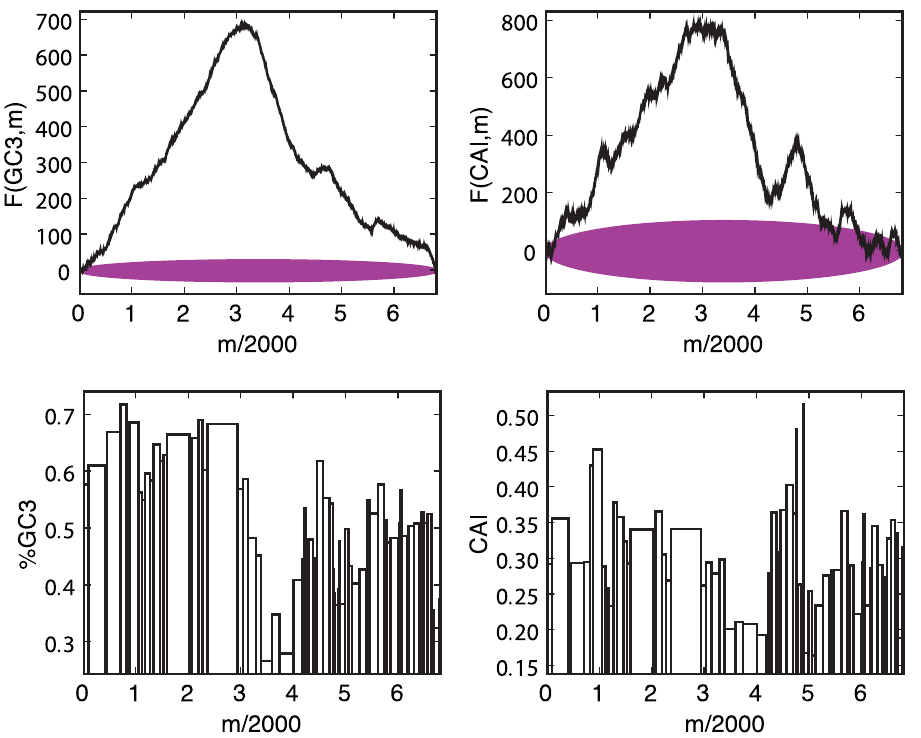
Figure 1. GC3 and CAI landscapes for lambda phage. Landscapes of GC3. (left) and CAI (right) measures of codon usage in Lambda phage. Only coding sequences are considered, which when concatenated together are 40,773 bp long (see Table 2). The GC3 landscape is the mean- centered cumulative sum of the GC3 content (GC3=1, AT3=0) of codons. The CAI landscape is the mean-centered cumulative sum of the log w - value for each codon. For each landscape, a region exhibiting an uphill slope corresponds to higher than average GC3 or CAI. The horizontal purple band represents the expected amount of variation in a random walk of GC3 or AT3 choices, given by Equation 2. Both landscapes exhibit features far outside of the purple bands, indicating that the patterns of codon usage are highly non-random. Gene boundaries are represented by the bars in the histograms below each landscape. The height of the bars in the histogram indicate the GC3 and CAI values for each gene.